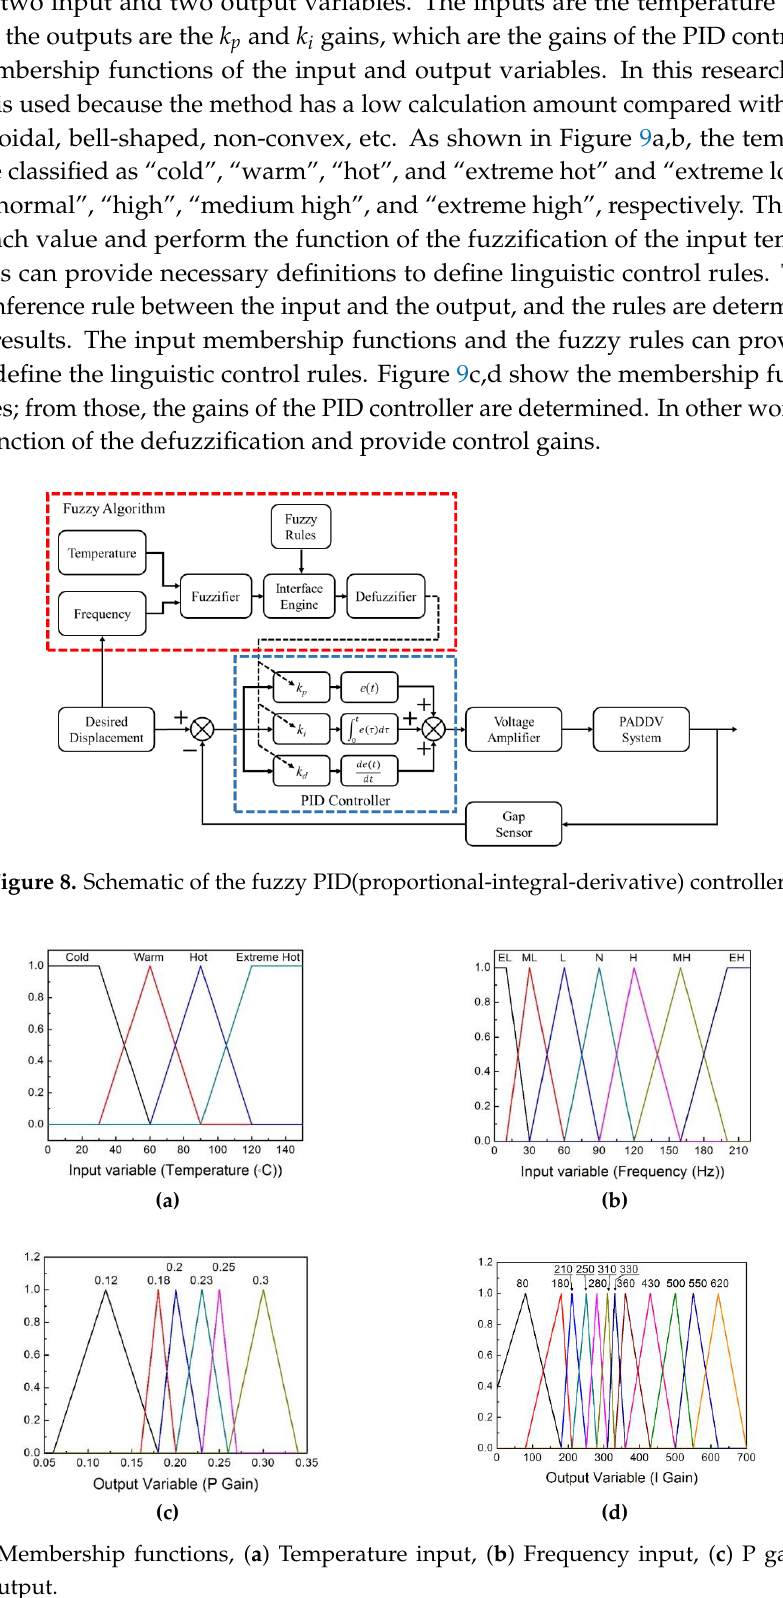
Figure 9. Membership functions, ( a ) Temperature input, ( b ) Frequency input, ( c ) P gain output, ( d ) I gain output.